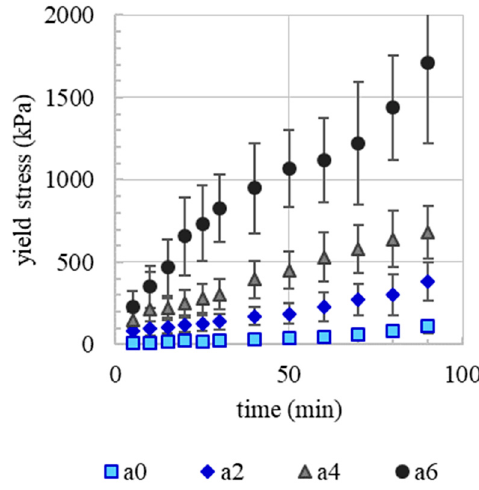
Figure 6. Yield stress evolution over time after deposition of sprayed strands containing 0% (a0), 2% (a2), 4% (a4) and 6% (a6) of the accelerator.